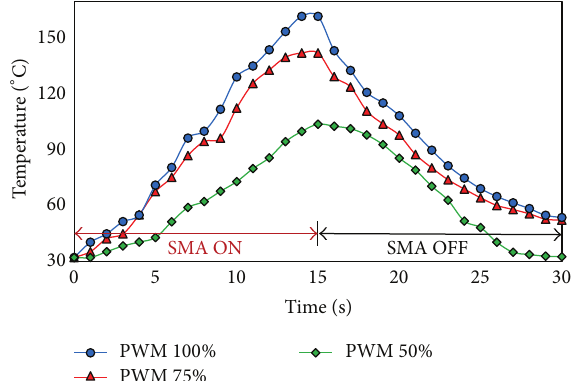
Figure 12: Thermal response of SMA actuator with different PWM duty cycles.